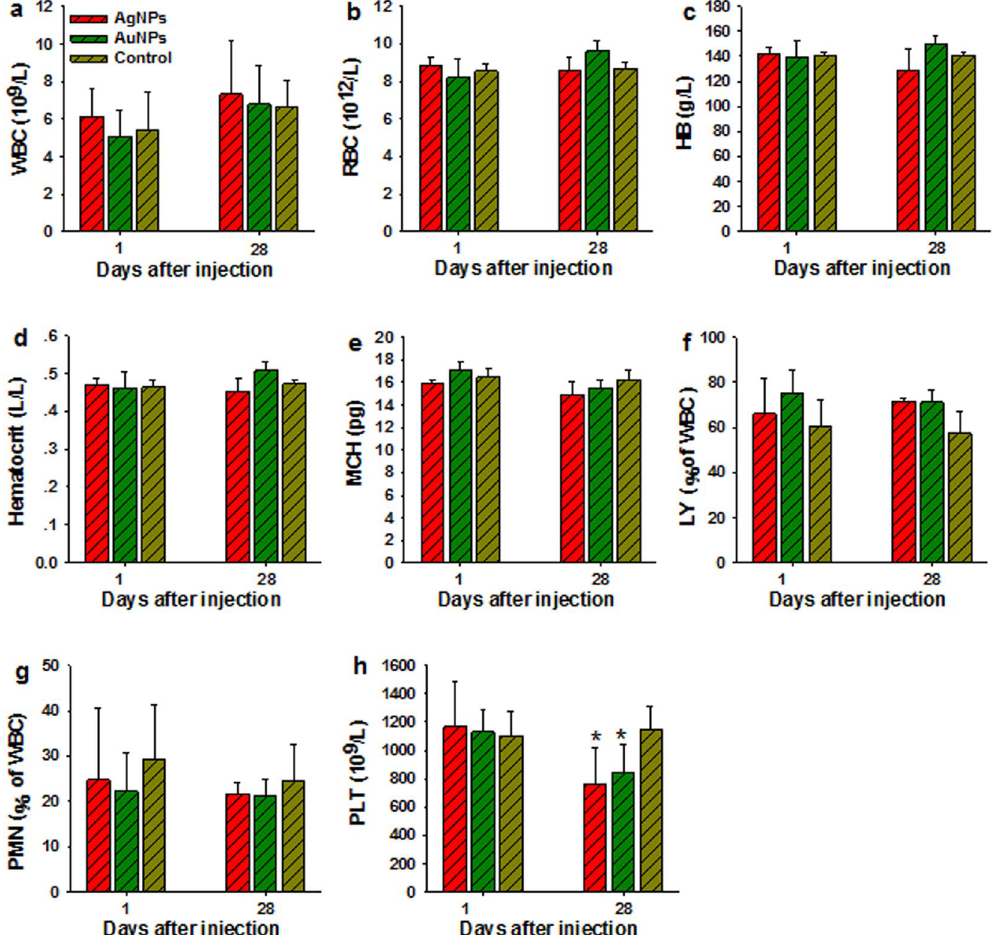
Figure 5. Whole blood analysis from animals treated with AgNPs and/or AuNPs and control. ( a–h ) Results exhibit mean and standard deviation of white blood cells count, WBC ( a ); red blood cells count, RBC ( b ); hemoglobin, HB ( c ); hematocrit ( d ); mean corpuscular hemoglobin, MCH ( e ), lymphocyte, LY ( f ); polymorphomultinuclear neutrophil granulocyte PMN ( g ), and platelet count, PLT ( h ), n =